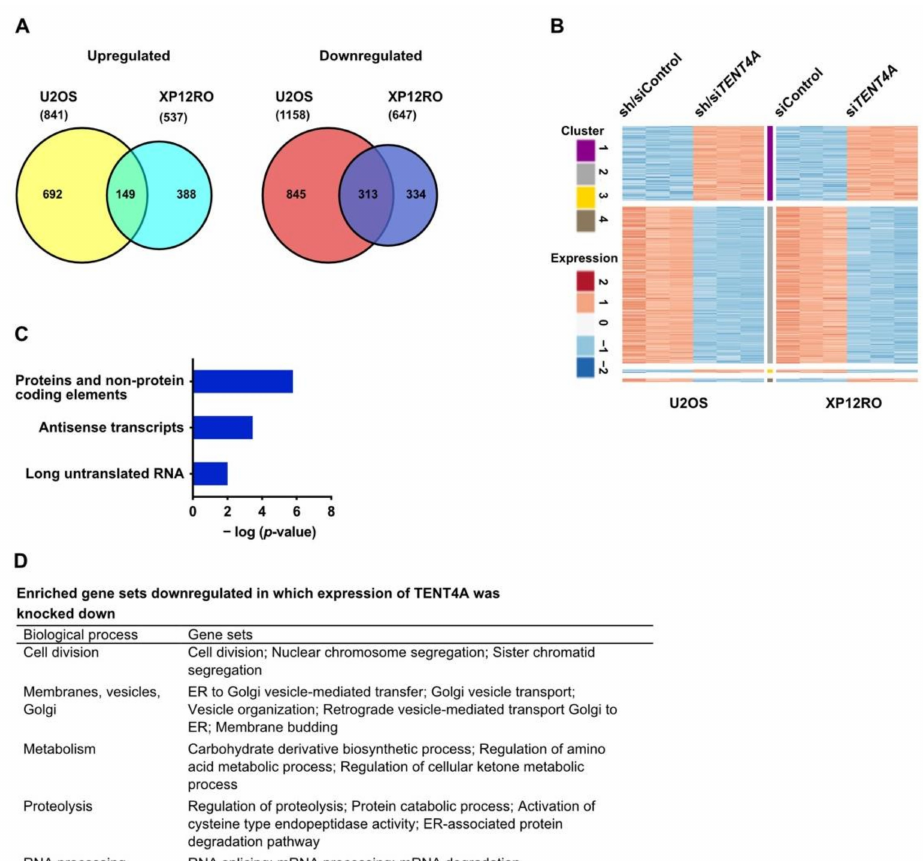
Figure 6. RNA-seq analysis of cells in which the expression of TENT4A was knocked down. ( A ) Venn diagram illustrating the number of significantly differentially expressed genes (FDR ≤ 0.05, absolute fold change ≥ 2 and a count of at least 30 at least in one of the samples) in TENT4A knocked down U2OS and XP12RO cells. The numbers of upregulated, downregulated and overlapping genes are shown (see detailed RNA-seq results in Supplementary Materials Data S1). ( B ) Heatmap representation of the shared significantly differentially expressed genes in U2OS and XP12RO experiments (a total of 475 genes). The response of most genes is the same in both cell lines (149 are upregulated and 313 are downregulated). For each experiment, the log2 normalized counts were standardized to have for each gene zero mean and unit standard deviation. K-mean clustering of the two data sets using Euclidean distance measure is presented. The expression profile is accompanied by a colored bar indicating the standardized log2 normalized counts. ( C ) Pathway Studio ontology of differentially expressed upregulated genes that are common to U2OS and XP12RO analyzed by Pathway Studio. Ontology details are in Supplementary Materials Data S2. ( D ) Gene sets enriched in downregulated genes in TENT4A knocked down U2OS and XP12RO cells. The mRNA degradation pathway was from the Pathway Studio analysis. See details data in Supplementary Materials Data